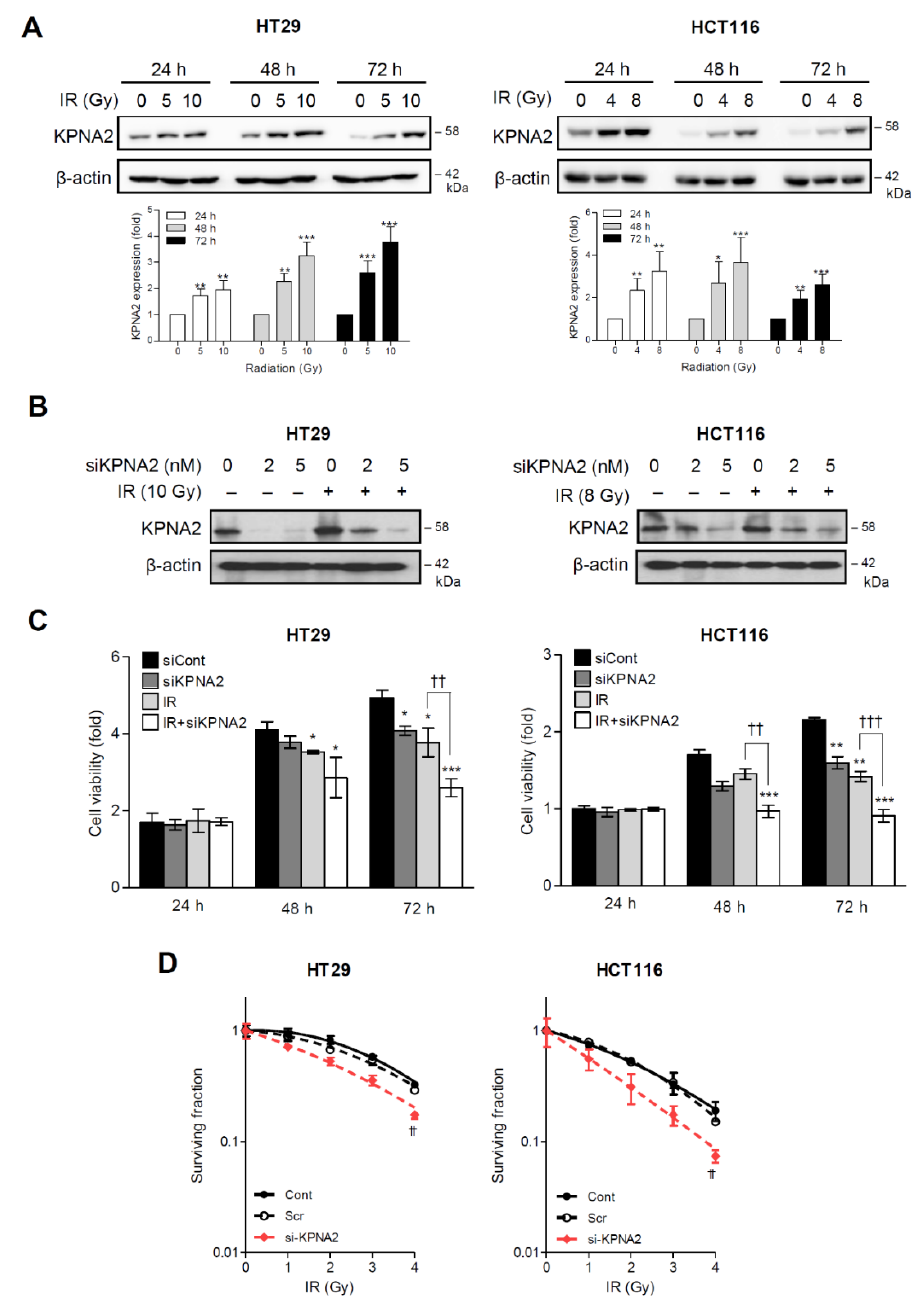
Figure 1. Inhibition of radiation-induced KPNA2 expression increases the radiosensitivity of human colorectal cancer cells. ( A ) The levels of KPNA2 in HT29 and HCT116 cells were determined by western blot analysis at the indicated times following ionizing radiation (IR). ( B ) Cells were transfected with KPNA2 siRNA (siKPNA2) for 24 h. The reduced expression of KPNA2 was confirmed by western blotting. ( C ) The cell viability of control siRNA (siCont, 5 nM)- or siKPNA2 (5 nM)-transfected cells with or without treatment with IR was measured by 3-(4,5-dimethylthiazol-2-yl) -2,5-diphenyltetrazolium bromide (MTT) assay at the indicated times. * p < 0.05, ** p < 0.01, *** p < 0.001 vs. control siRNA-transfected group, †† p < 0.01, ††† p < 0.001 vs. irradiated group. ( D ) The clonogenic survival fraction was evaluated in HT29 or HCT116 cells transfected with control or KPNA2 siRNA for 24 h following IR. The data show representative results and are presented as mean ± SD of three independent experiments. †† p < 0.01 vs. control siRNA-transfected group.